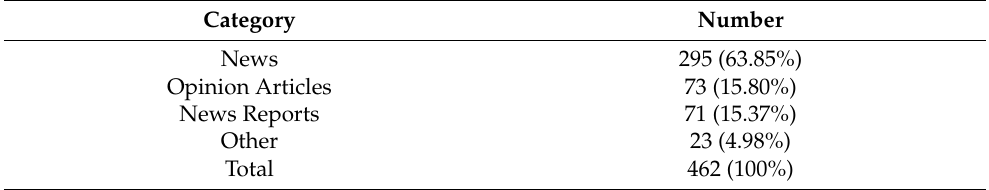
Table 4. Journalistic Genre.